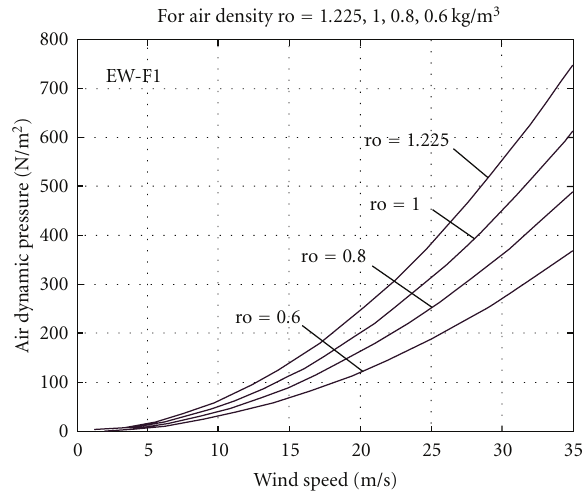
Figure 9: Wind dynamic pressure versus wind speed and air density ρ . The ro = 0.6 is for H ≈ 6 km.